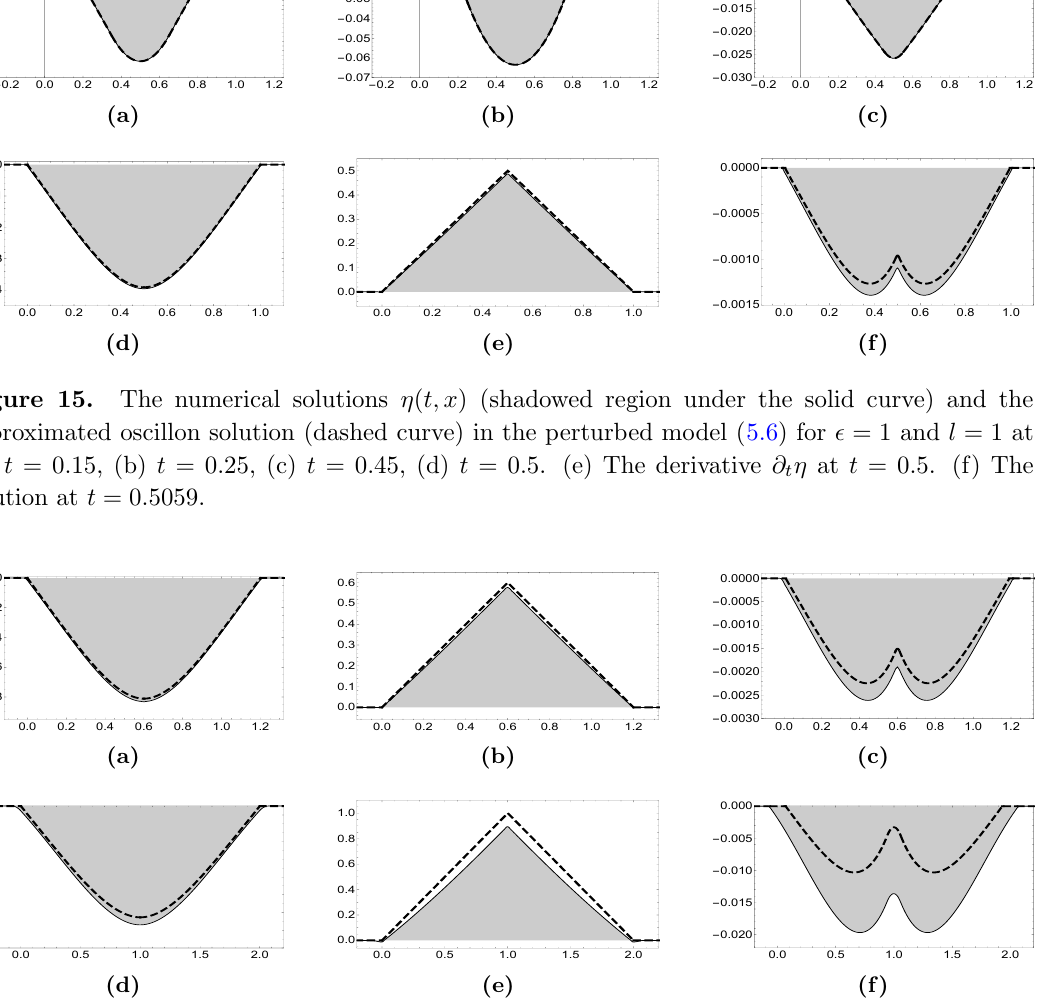
Figure 16. The numerical solutions (shadowed region under the solid curve) and the approximated oscillon solution (dashed curve) in the perturbed model (5.6) for (cid:15) = 1 and l = 1 : 2 (a,b,c) and l = 2 : 0 (d,e,f) where (a,d) show the (cid:12)eld (cid:17) ( t; x ) at t = l , (c) at t = 0 : 611, (f) at t = 1 : 059. (b, e) The 2 derivative @ t (cid:17) at t = l 2